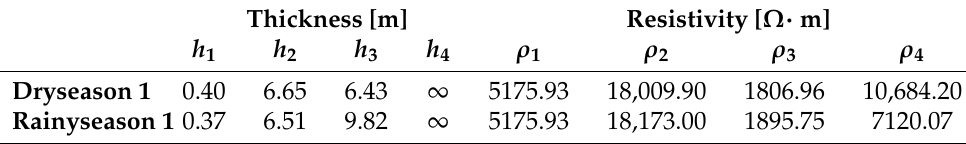
Table 2. Thickness and resistivity values per layer for dry and rainy